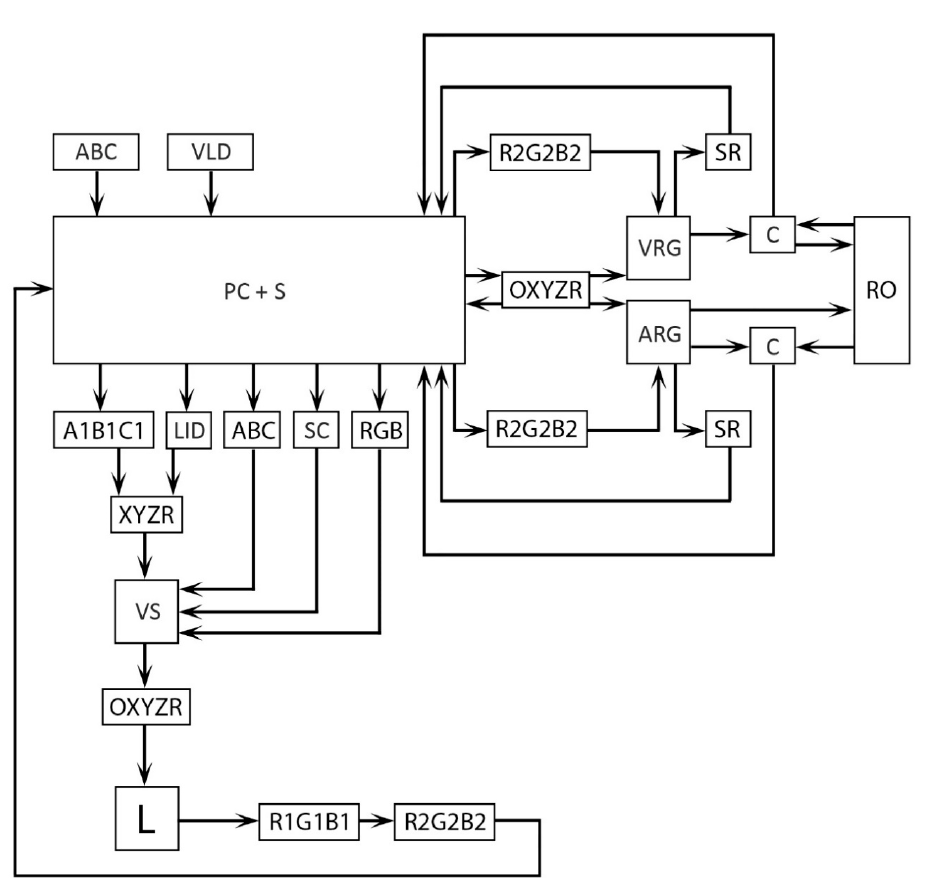
Figure 10. Block circuit of object illumination system designing by Virtual and Augmented Reality. ARG—Augmented Reality Glasses.